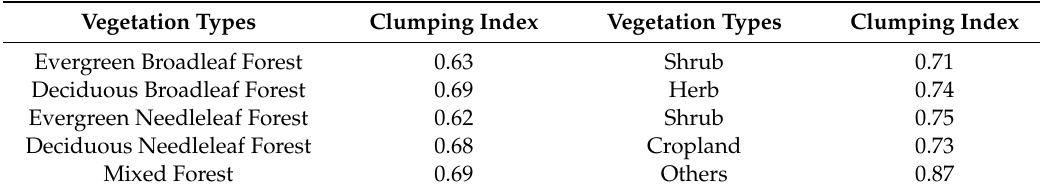
Table 3. Clumping index based on di ff erent vegetation